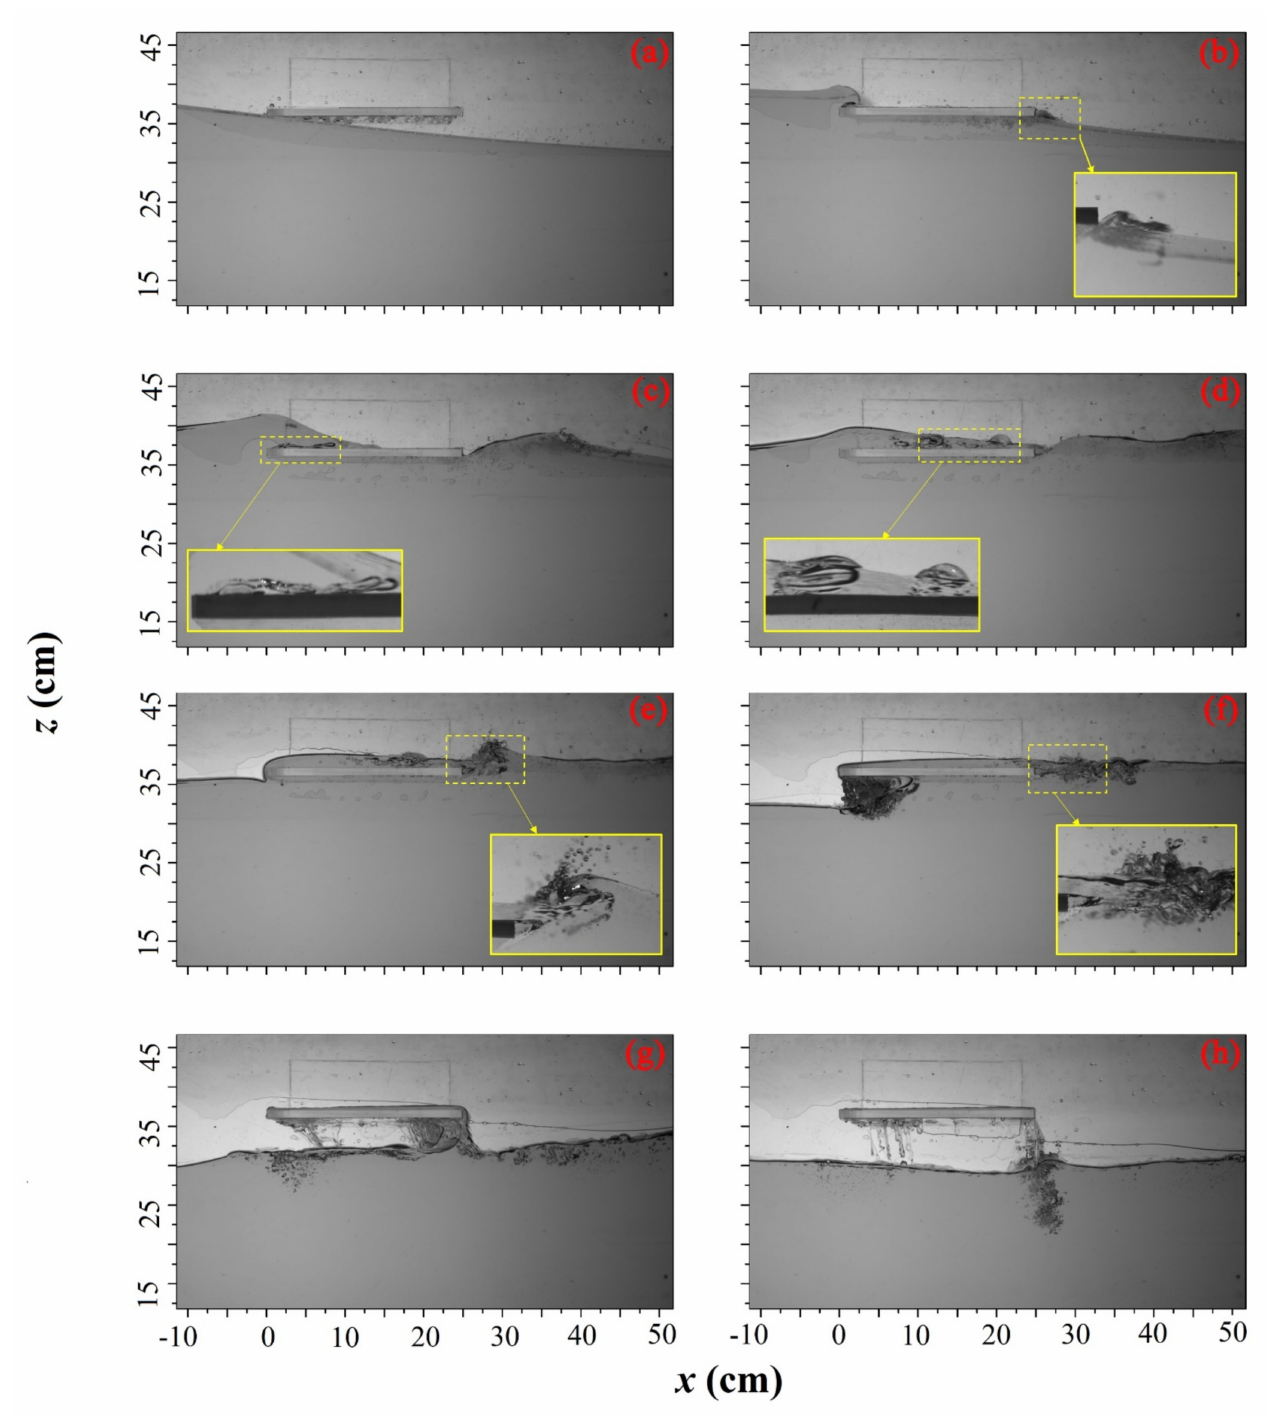
Figure 2. Snapshots of aerated flow evolution around the plate of Case 1, D / h = 6/30, H / h = 10/30. T = ( a ) 0, ( b ) 0.17, ( c ) 0.42, ( d ) 0.62, ( e ) 0.74, ( f ) 0.95, ( g ) 1.45, ( h )